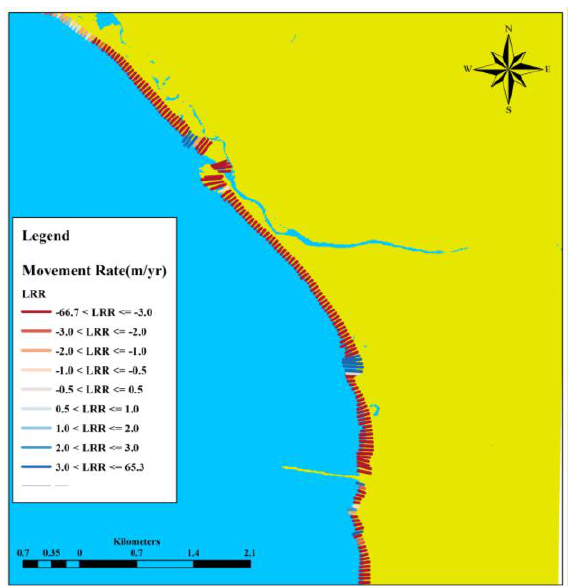
Figure 9. The rate of change along transects using color map (negative values in red indicate retreat and positive values in blue indicate